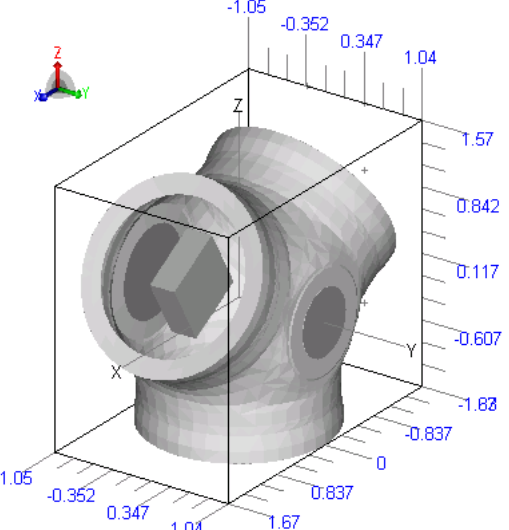
Figure 2. Electromagnetic model of wind turbine hub. Figures on the grid show the dimensions of the hub in